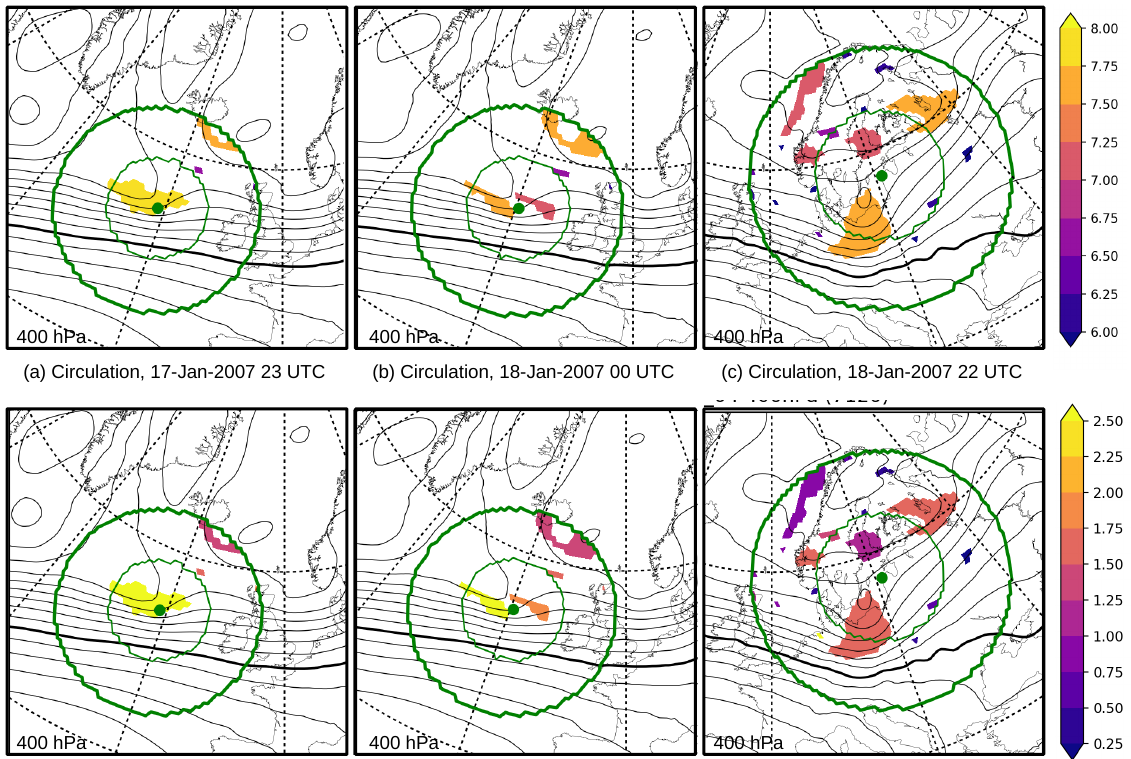
Figure 9. Vortices identified in CFSR data at 400 hPa for specific time steps color shaded ( a – c ) by their circulation magnitude (Log10(circulation (m 2 s − 1 ))) and ( d – f ) by their mean vorticity (10 − 4 s − 1 ). Only vortices are plotted that lie within the radius around Kyrill’s NCEP circulation center (green dot). The inner green circle represents the effective radius of Kyrill (as calculated in NCEP), and the outer green circle is given by the doubled effective radius. Black contours: geopotential height in 80-m intervals with the thick black contour equal to